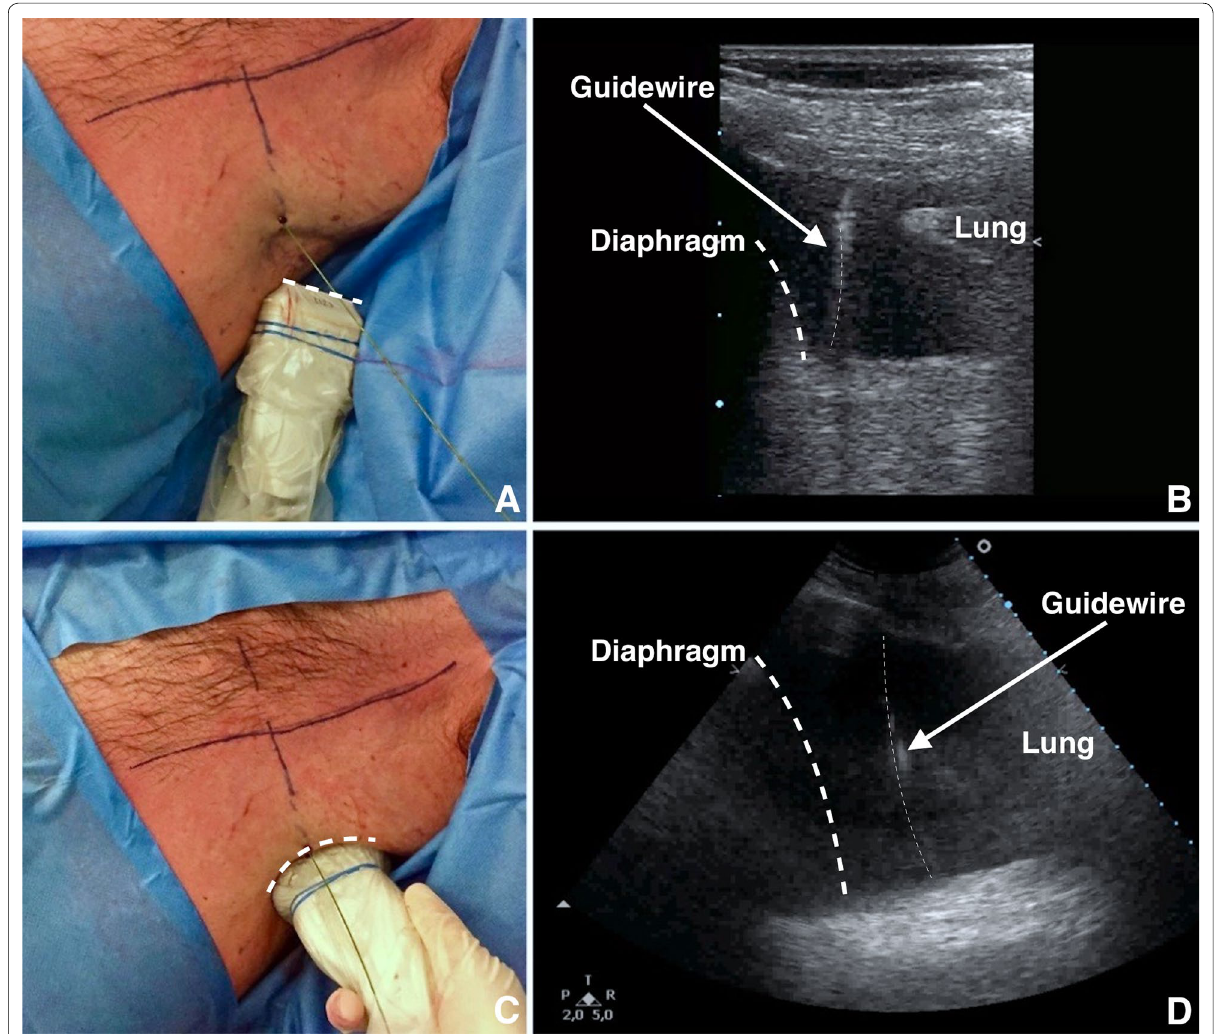
Fig. 5 A Remove the syringe from the needle and pass the guidewire through the needle. After inserting the guidewire, remove the needle, leaving the guidewire in place. B Employing a high-frequency US transducer (linear probe) it is possible to visualise the insertion of the guidewire in real-time. C Shift to low-frequency US transducer (convex probe) to define the final position of the guidewire using US. It is mandatory to check the correct insertion of the guidewire at the end of the procedure. D As shown, the guidewire is correctly positioned within pleural